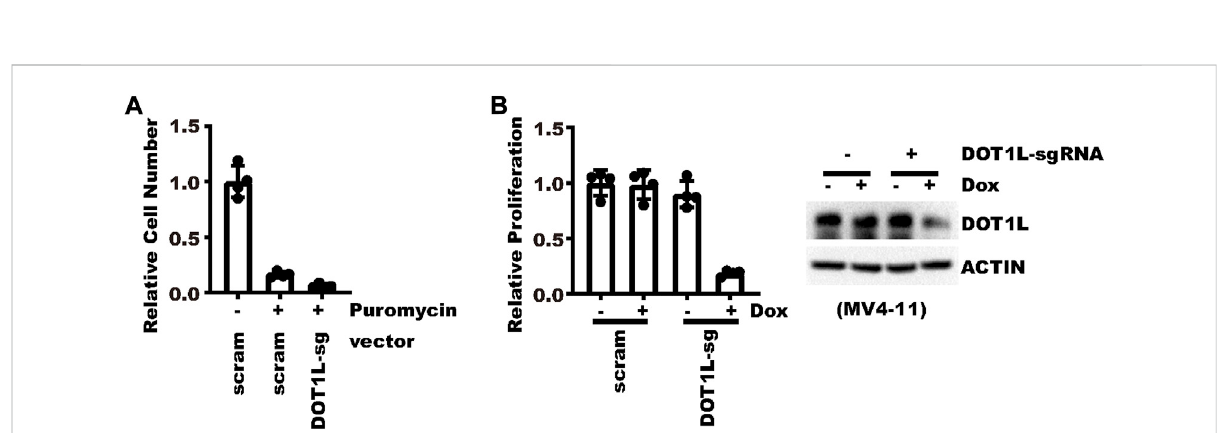
Indispensable genes could be ef fi ciently knocked-down in cells hard to transduce. (A) Same number of MV4-11 cells were transduced with a virusexpressingconstitutiveDOT1L-sgRNAorcontrolsgRNA. Cellswerethen selected with1 μ g/mlpuromycin for5 days.Shownistherelativefold ofproliferationafterselectionascomparedtothegroupwithoutpuromycinselection. (B) SamenumberofMV4-11cellsweretransducedwithavirus expressing pLenti-TRE-CasRx-DOT1L-sgRNA or control vector. Cells were then selected with 1 μ g/ml puromycin for 5 days. Afterward,